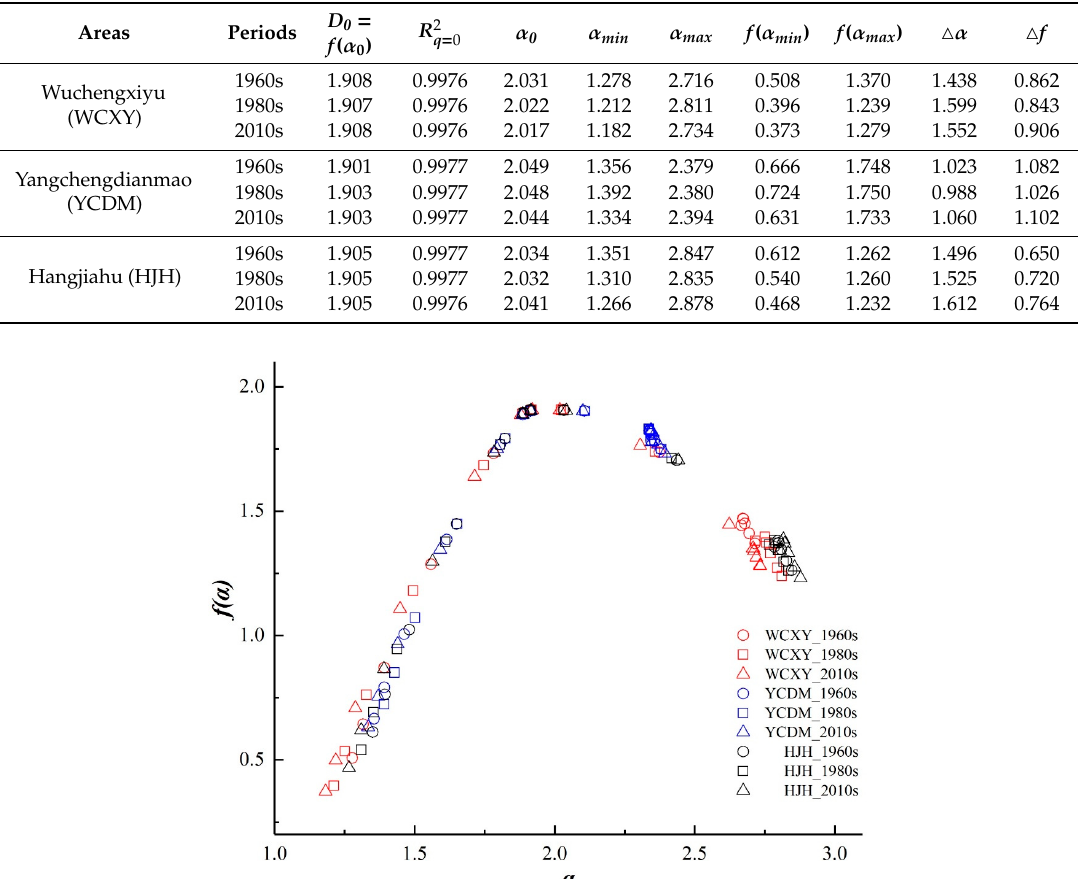
Figure 6. The multifractal spectrum of the studied river networks in 1960s, 1980s, and 2010s.